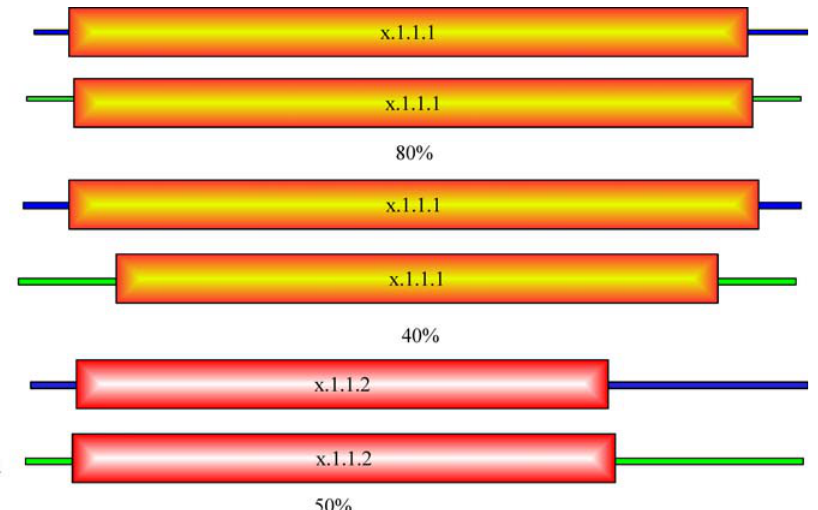
Figure 6. Average Divergence